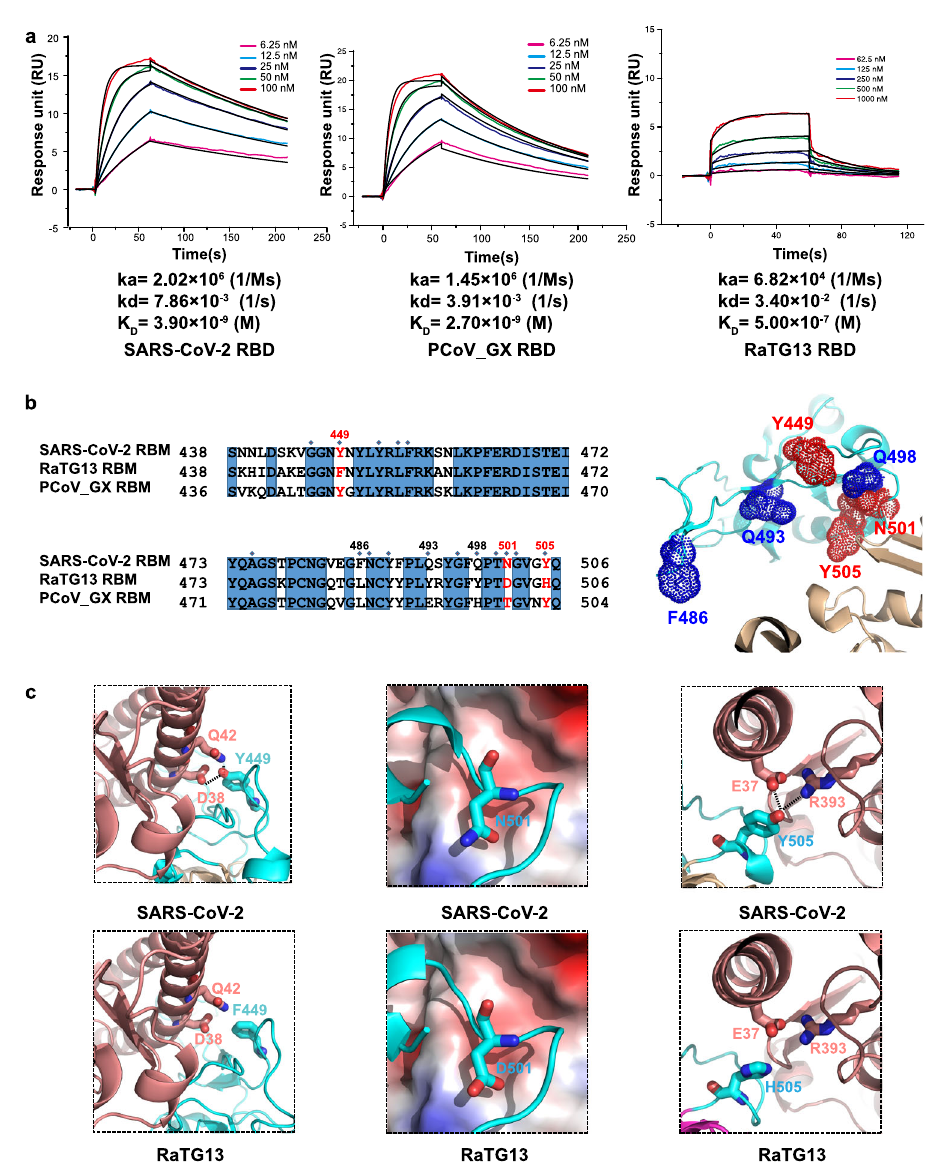
Fig. 5 Binding af fi nities and interactions of human ACE2 with different RBDs. a Binding curves of immobilized human ACE2 with the SARS-CoV-2 (left panel), PCoV_GX (middle panel), or RaTG13 (right panel) RBD. Data are shown as different colored lines and the best fi t of the data to a 1:1 binding model is shown in black. b Sequence alignment of the RBMs from the SARS-CoV-2, PCoV_GX, and RaTG13 spikes (left panel). Residues in the SARS-CoV-2 RBM that contact with hACE2 are indicated by red dots. The SARS-CoV-2 RBD (colored in cyan) and hACE2 (colored in wheat) are shown as cartoon (right panel, PDB ID: 6M0J). Six residues Y449, F486, Q493, Q498, N501, and Y505 in the RBM of SARS-CoV-2 that are not conserved in the RaTG13 are shown as dots. c Important sites accounting for different binding strength of hACE2 with the RaTG13 and SARS-CoV-2 RBDs (SARS-CoV-2 RBD-hACE2 interface: PDB ID 6M0J). The RBDs are showed as cyan cartoon and the hACE2 is showed in wheat cartoon or surface with electrostatic potential. Hydrogen bonds between SARS-CoV-2 Y449 and hACE2 D38 and Q42 would be abolished after Y to F mutation in the RaTG13 RBM (two leftmost panels). SARS-CoV-2 N501 mutation to D501 in RaTG13, contacting the hACE2 local negatively charged surface would disfavor the binding of hACE2 with the RaTG13 RBD (two middle panels). Hydrogen bonds between SARS-CoV-2 Y505 and hACE2 E37 and R393 would be abolished after Y to H mutation in the RaTG13 RBM (two rightmost